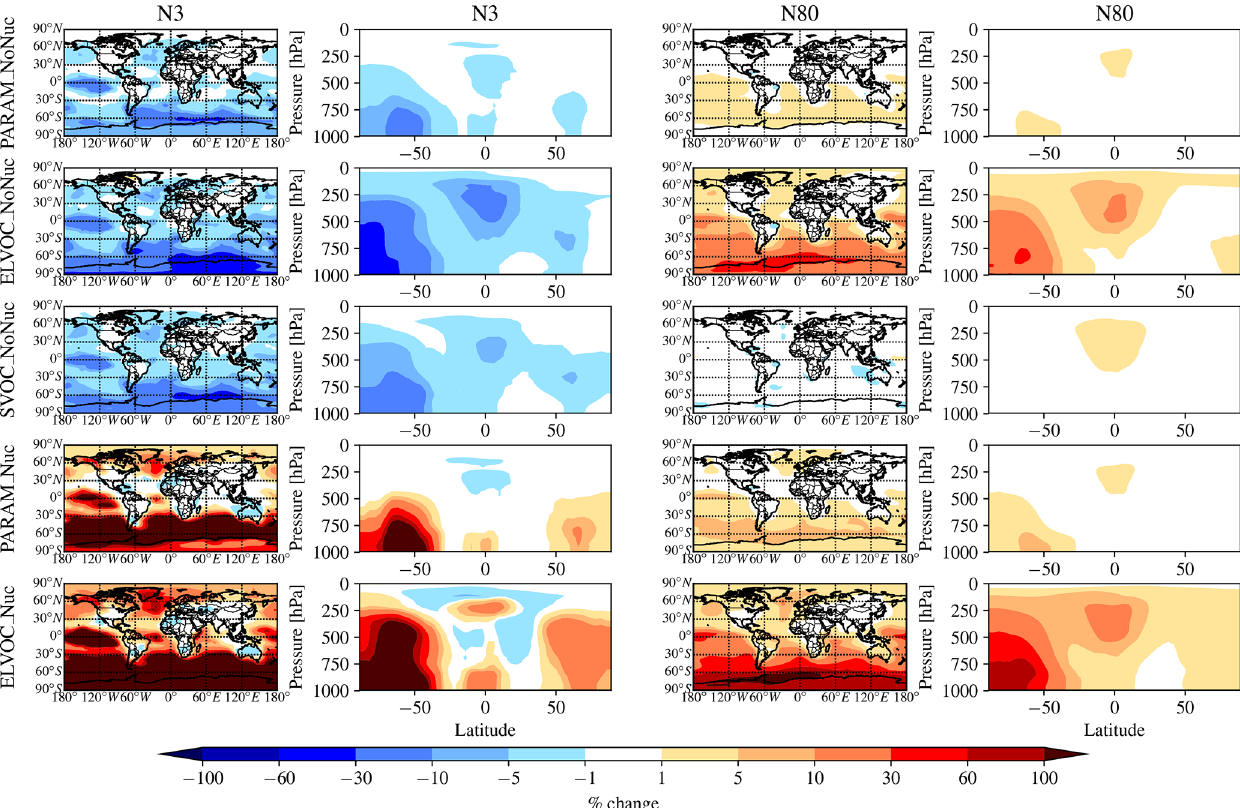
Figure 3. Global annual mean percent change in N3 and N80 at 900hPa (first and third columns) and global zonal annual mean per- cent change (second and fourth columns) between DEFAULT_NoMSA and PARAM_NoNuc (first row), ELVOC_NoNuc (second row), SVOC_Nuc (third row), PARAM_Nuc (fourth row), and ELVOC_Nuc (fifth row) (warm colors indicate an increase in N3/N80 as compared to DEFAULT_NoMSA). First and second columns: N3 (the number concentration of particles with diameters larger than 3nm). Third and fourth columns: